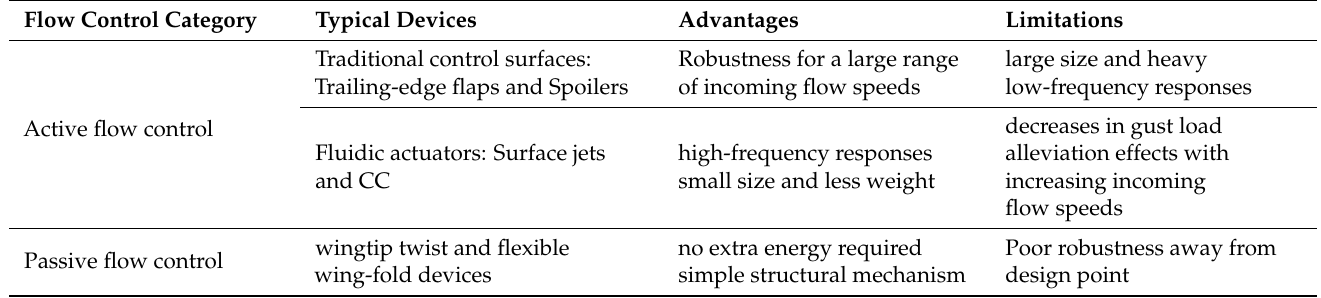
Table 1. Comparisons of the characteristics of the flow control devices for gust load